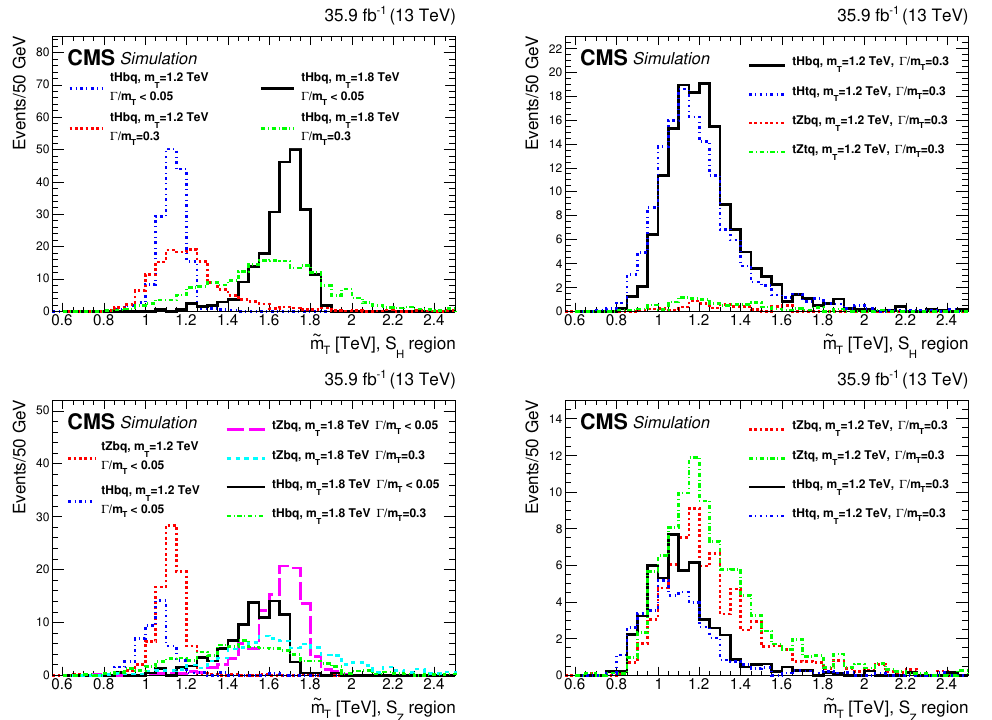
Figure 5 . Example m distributions in the signal regions, S (upper row), and S (lower row). e T H Z For presentation purposes, the cross sections for tHbq, tZbq, tHtq and tZtq are set equal to 1 pb for all masses and fractional widths and normalized to the integrated luminosity of the data set. The left column illustrates potential signals with a range of masses and widths for the tHbq and tZbq channels. The right column illustrates potential signals for one mass and a large width for all four processes including also tHtq and